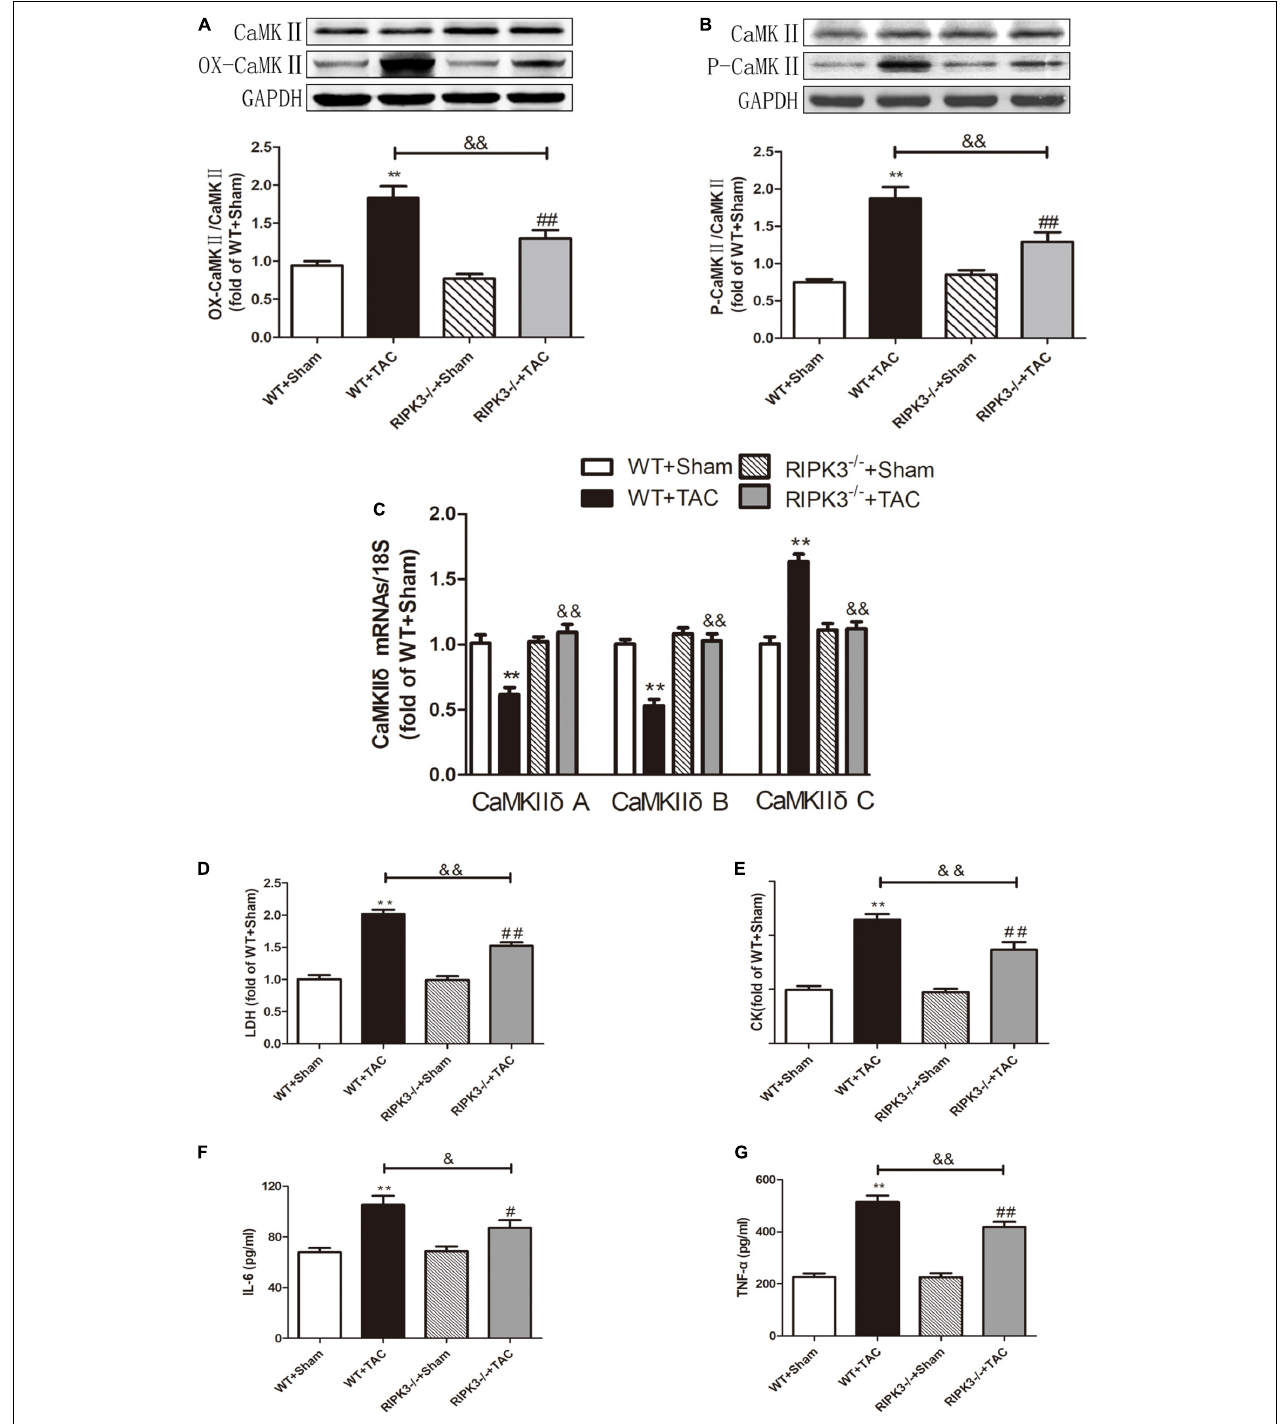
FIGURE 6 | Depletion of RIPK3 can alleviate the elevated levels of CaMKII oxidation and phosphorylation, improve the CaMKII δ alternative splicing disorder in HF mice and the degree of myocardial injury and inflammatory response. Male 8-week-old WT and RIPK3 − / − mice were treated with TAC using a 28-g needle. The control group received sham surgery. All groups of mice were given continuous feeding for 6 weeks. Hearts were then obtained for correlative testing. (A) The expression of OX-CaMKII at the protein level in myocardial tissue was detected by Western blotting analysis, and GAPDH was used as a loading control. (B) The expression of P-CaMKII at the protein level in myocardial tissue was detected by Western blotting analysis, and GAPDH was used as a loading control. (C) Detection of myocardial CaMKII δ A, CaMKII δ B, and CaMKII δ C at the mRNA level by qRT-PCR, and 18S was used as the housekeeping gene. (D) The levels of serum LDH, (E) CK, (F) IL-6, and (G) TNF- α . Compared with WT + sham group, ** P < 0.01; compared with RIPK3 − / − + sham group, ## P < 0.01 and # P < 0.05; compared with WT + TAC group, && P < 0.01 and & P < 0.05. n = 6.